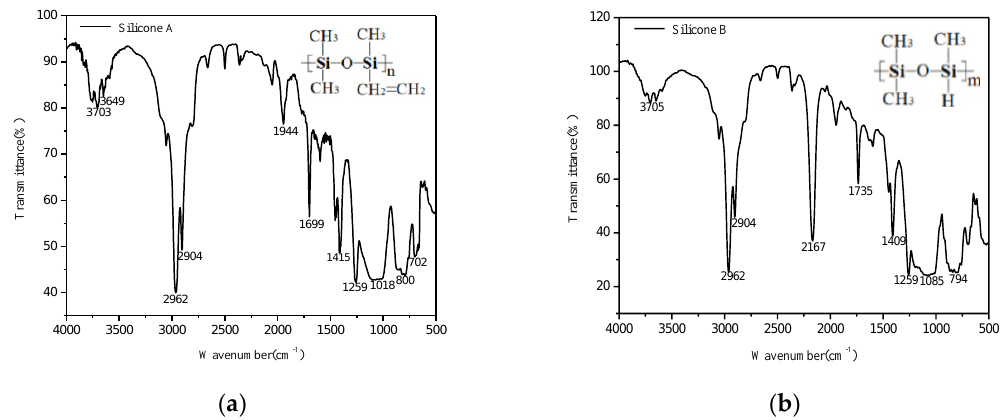
Figure 7. The FTIR spectrum of silicones and their molecular formula ( a ) silicone A; ( b ) silicone B. Table 1. Characteristic peaks of silicone A and B in the FTIR spectrum.